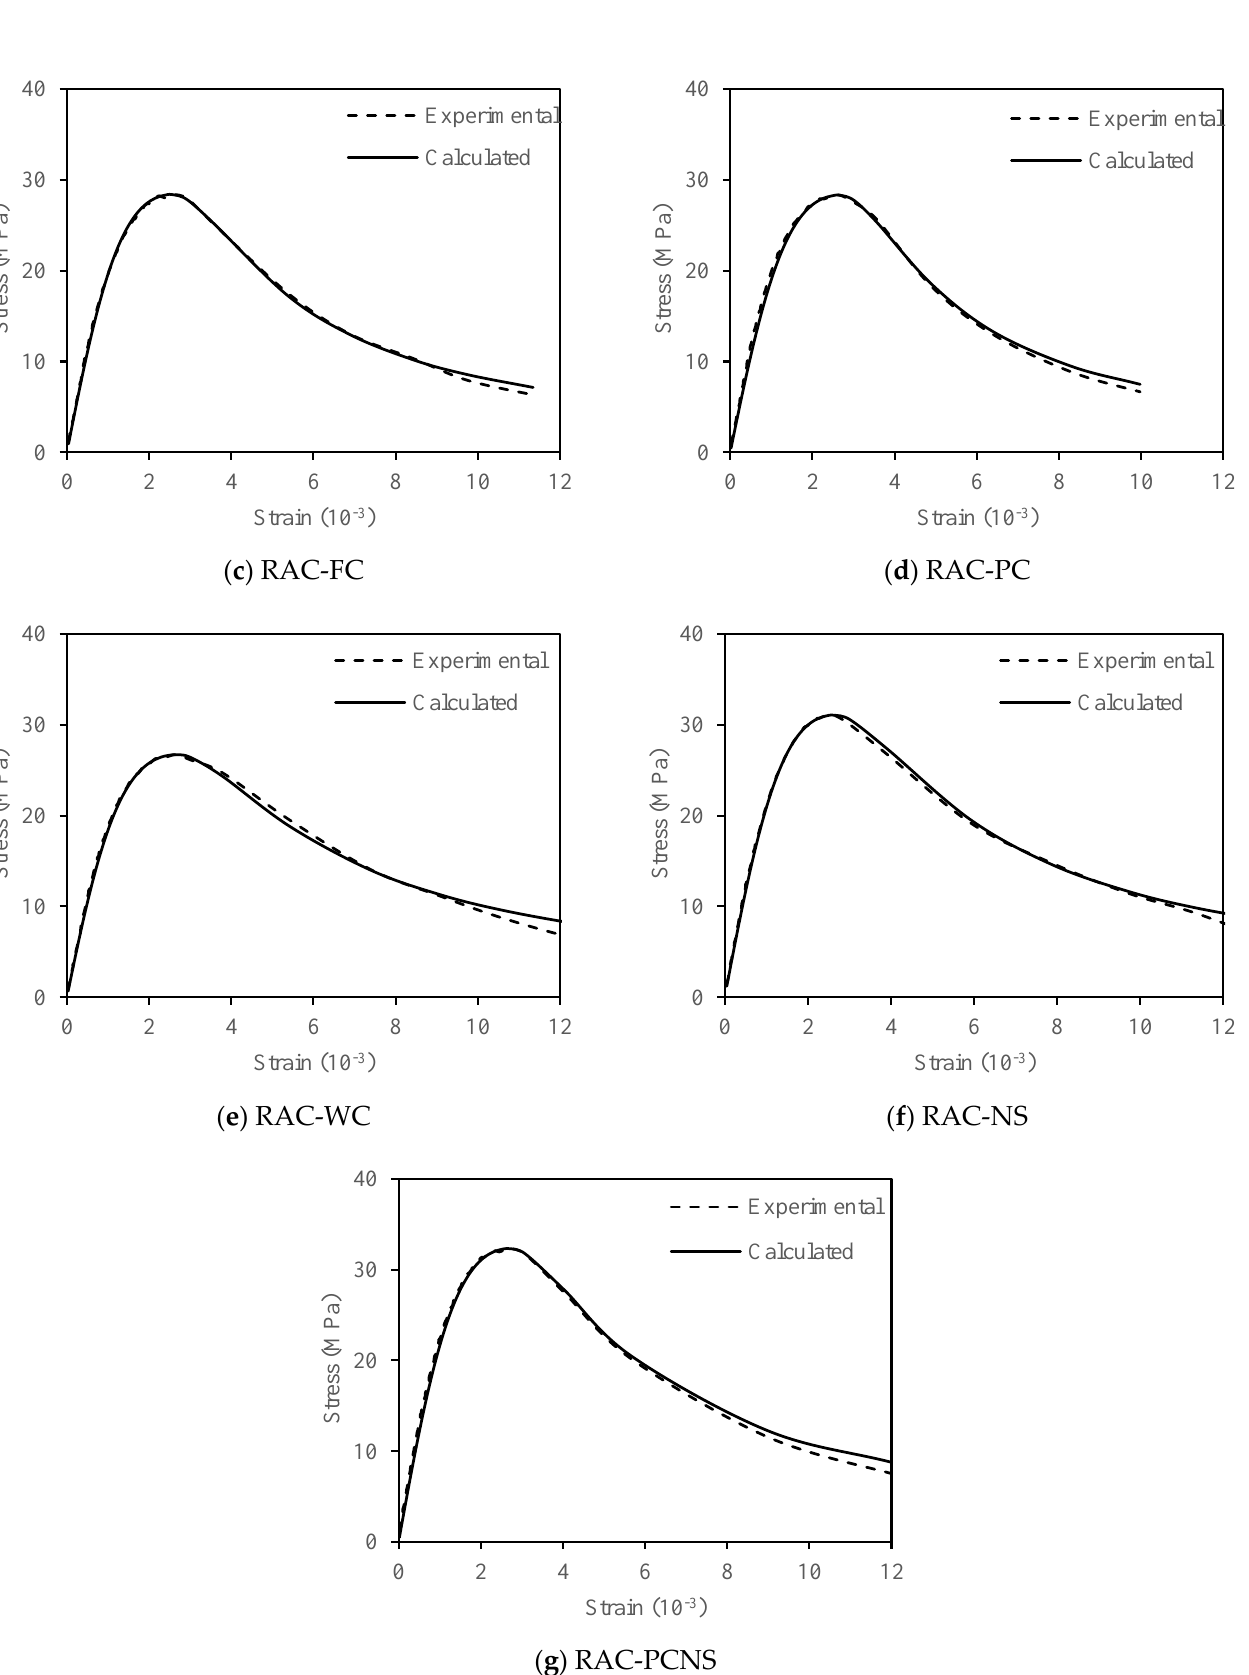
Figure 11. Experimental and calculated stress – strain curve.